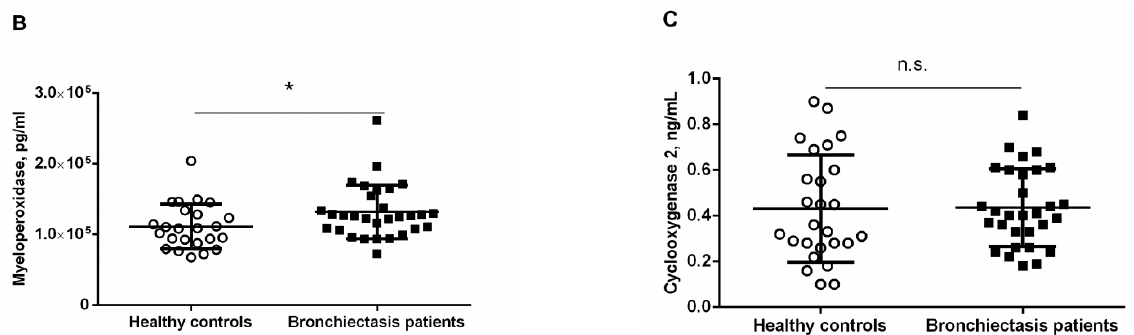
Figure 5. ( A ) Correlation matrix of biological and analytical variables, in which positive correlations are represented in blue, while negative correlations are represented in red. The intersection within the circle represents p value > 0.05. Color intensity and the size of the circle are proportional to the correlation coefficients, as indicated in the Y axis on the right-hand side of the graph. Mean values and standard deviations of plasma ( B ) myeloperoxidase levels (pg/mL) and ( C ) cyclooxygenase levels (ng/mL) in healthy controls and bronchiectasis patients. Statistical significance: * p ≤ 0.05 between bronchiectasis patients and control subjects and n.s., non-significant differences between the study groups.